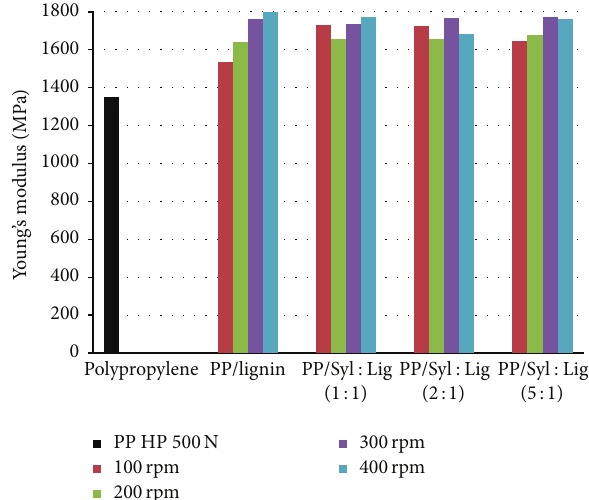
Figure 10: Young modulus obtained during static uniaxial deforma- tion versus applied screw